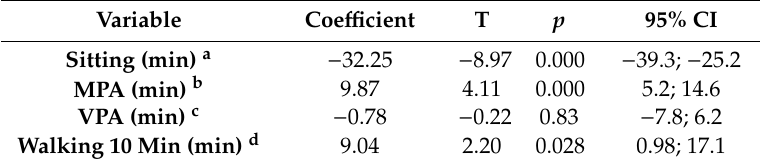
health); and year (2012/2017) were included as factors. Factors that were not significant were removed from the model in a step-wise fashion with the least significant factor removed first, until all remaining factors were significant. Final models include the following significant factors: a. Year; b.